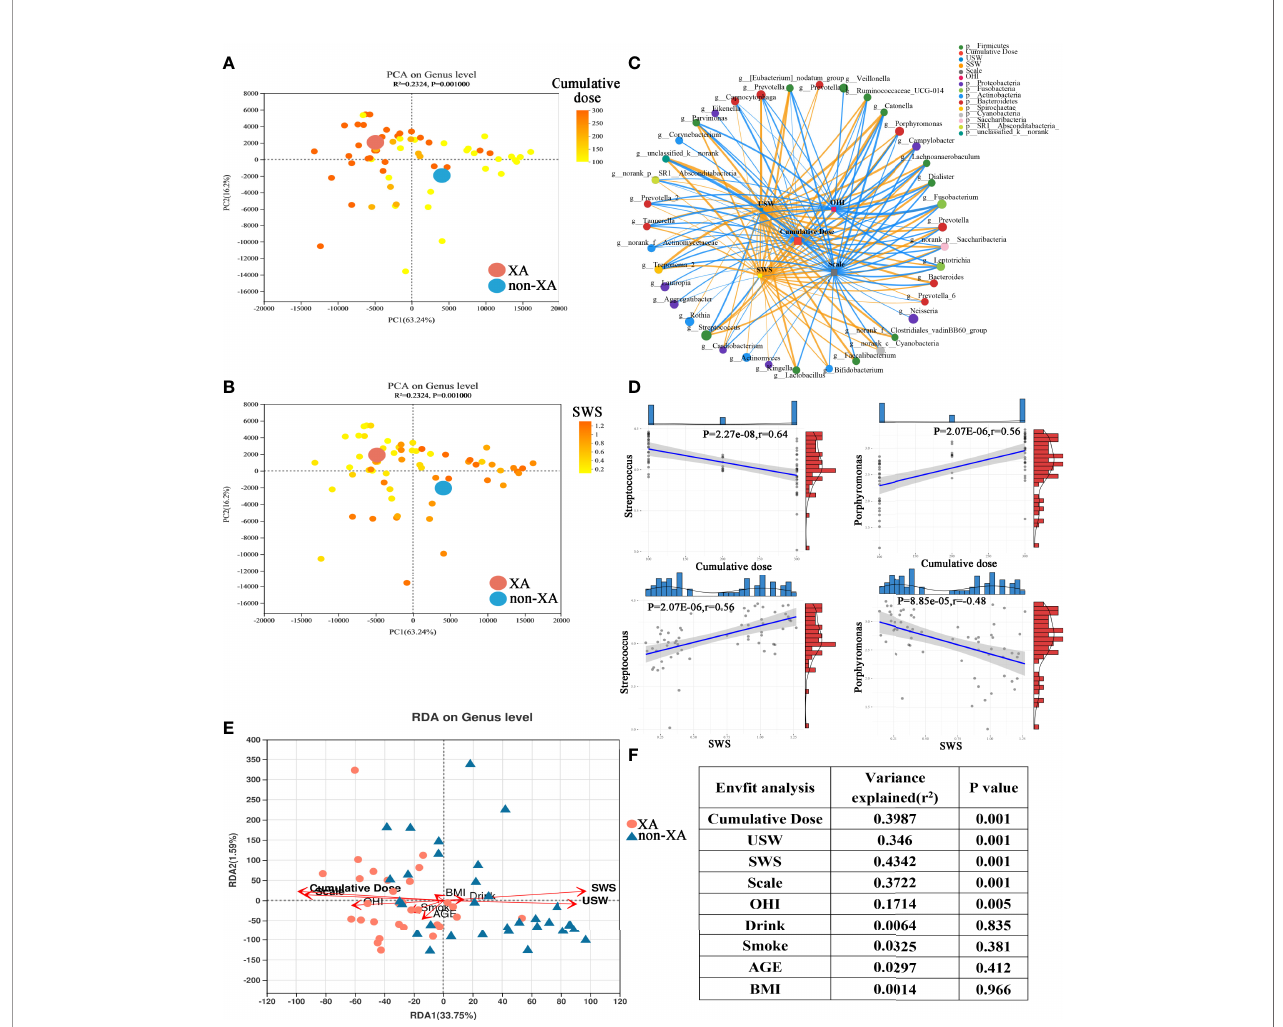
FIGURE 4 | Association of oral microbiota with clinical parameters. PCoA as in ( Figure S3D ), colored according to cumulative radioiodine dose (mCi) (A) and stimulated whole salivary secretion (SWS, mL/min) (B) . (C) Spearman ’ s correlation between the top 40 abundant oral microbial genera and clinical parameters was shown through a co-correlation network. The width of the line represented the magnitude of correlations, orange indicated a positive correlation, and light blue indicated a negative correlation; the size of the nodes indicated the relative abundance of the genus, and the correlation threshold was set to 0.3. (D) Linear correlation analysis revealed a signi fi cant correlation between streptococcus , porphyromonas , and cumulative radioiodine dose, SWS in XAs and non-XAs. (E) Triplots of redundancy analysis. Explanatory variables were shown in orange. (F) ANOVA-like signi fi cance test of the explanatory variables. PCoA, Principal coordinate analysis; XAs, xerostomia patients; non-XAs, patients without